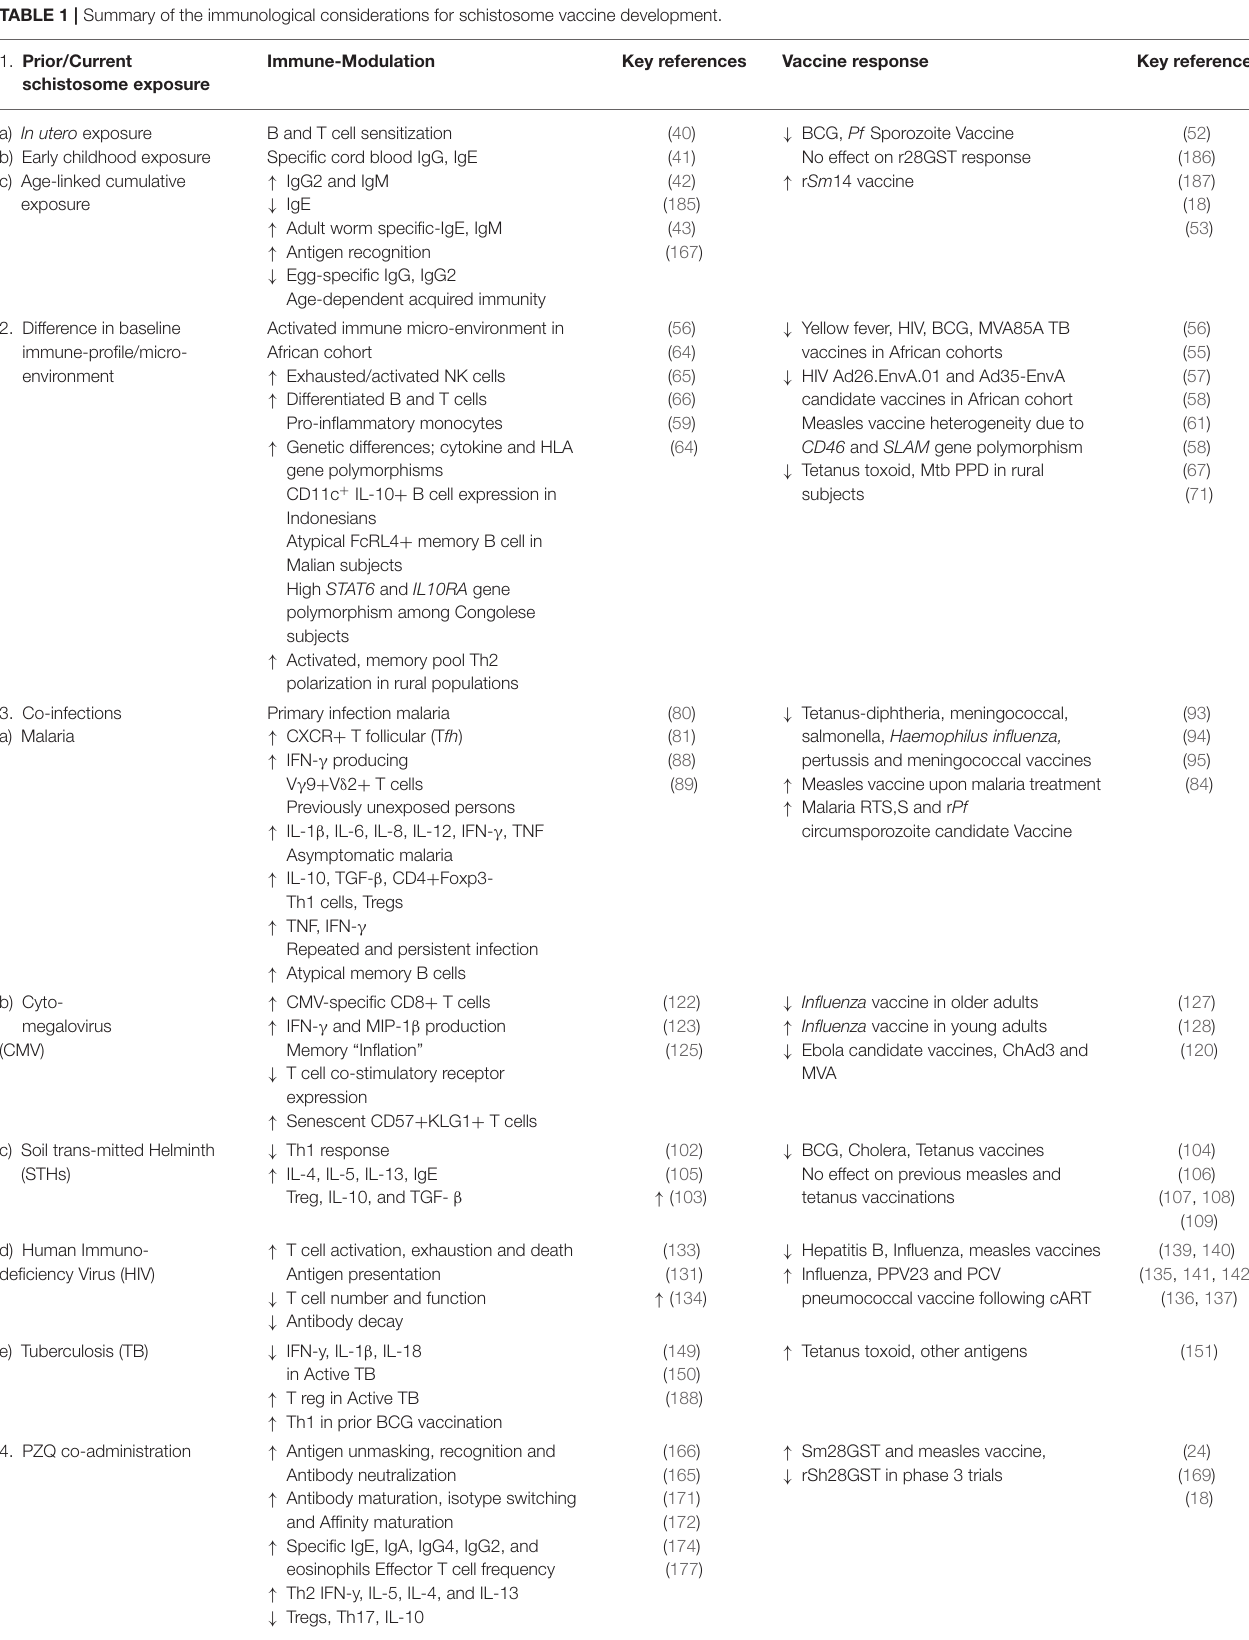
TABLE 1 | Summary of the immunological considerations for schistosome vaccine